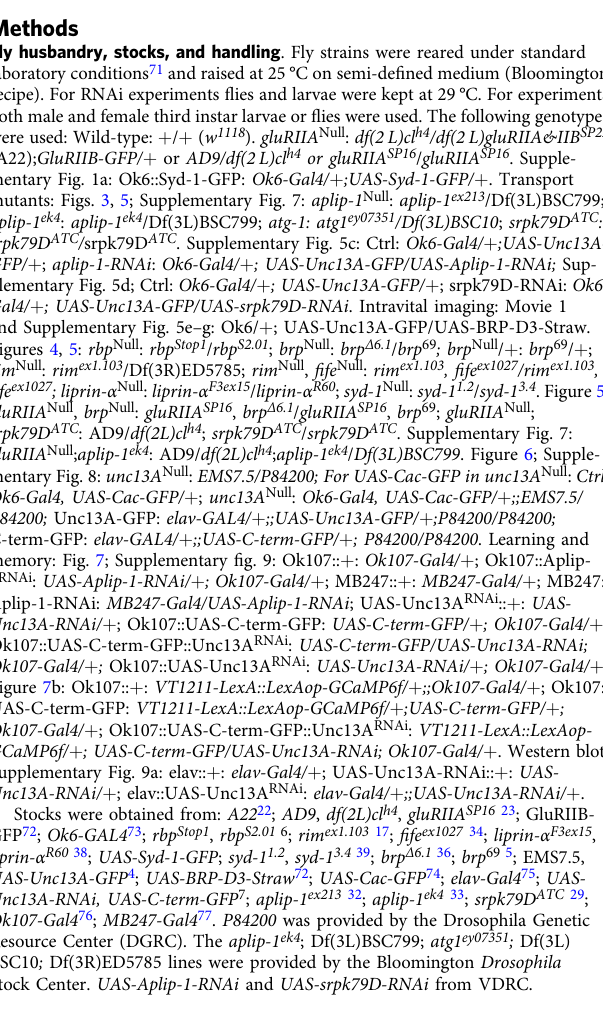
mentary Fig. 1a: Ok6::Syd-1-GFP: Ok6-Gal4/ + ;UAS-Syd-1-GFP/ + . Transport mutants: Figs. 3, 5; Supplementary Fig. 7: aplip-1 Null : aplip-1 ex213 /Df(3L)BSC799; aplip-1 ek4 : aplip-1 ek4 /Df(3L)BSC799; atg-1: atg1 ey07351 /Df(3L)BSC10 ; srpk79D ATC : srpk79D ATC / srpk79D ATC . Supplementary Fig. 5c: Ctrl: Ok6-Gal4/ + ;UAS-Unc13A- GFP/ + ; aplip-1-RNAi : Ok6-Gal4/ + ; UAS-Unc13A-GFP/UAS-Aplip-1-RNAi; Sup- plementary Fig. 5d; Ctrl: Ok6-Gal4/ + ; UAS-Unc13A-GFP/ + ; srpk79D-RNAi: Ok6- Gal4/ + ; UAS-Unc13A-GFP/UAS-srpk79D-RNAi . Intravital imaging: Movie 1 and Supplementary Fig. 5e – g: Ok6/ + ; UAS-Unc13A-GFP/UAS-BRP-D3-Straw. Figures 4, 5: rbp Null : rbp Stop1 / rbp S2.01 ; brp Null : brp Δ 6.1 / brp 69 ; brp Null / + : brp 69 / + ; rim Null : rim ex1.103 /Df(3R)ED5785; rim Null , fi fe Null : rim ex1.103 , fi fe ex1027 /rim ex1.103 , fi fe ex1027 ; liprin- α Null : liprin- α F3ex15 / liprin- α R60 ; syd-1 Null : syd-1 1.2 / syd-1 3.4 . Figure 5: gluRIIA Null , brp Null : gluRIIA SP16 , brp Δ 6.1 / gluRIIA SP16 , brp 69 ; gluRIIA Null ; srpk79D ATC : AD9/ df(2L)cl h4 ; srpk79D ATC / srpk79D ATC . Supplementary Fig. 7: gluRIIA Null ; aplip-1 ek4 : AD9/ df(2L)cl h4 ; aplip-1 ek4 / Df(3L)BSC799 . Figure 6; Supple- mentary Fig. 8: unc13A Null : EMS7.5/P84200; For UAS-Cac-GFP in unc13A Null : Ctrl: Ok6-Gal4, UAS-Cac-GFP/ + ; unc13A Null : Ok6-Gal4, UAS-Cac-GFP/ + ;;EMS7.5/ P84200; Unc13A-GFP: elav-GAL4/ + ;;UAS-Unc13A-GFP/ + ;P84200/P84200; C-term-GFP: elav-GAL4/ + ;;UAS-C-term-GFP/ + ; P84200/P84200 . Learning and memory: Fig. 7; Supplementary fi g. 9: Ok107:: + : Ok107-Gal4/ + ; Ok107::Aplip- 1 RNAi : UAS-Aplip-1-RNAi/ + ; Ok107-Gal4/ + ; MB247:: + : MB247-Gal4/ + ; MB247:: Aplip-1-RNAi: MB247-Gal4/UAS-Aplip-1-RNAi ; UAS-Unc13A RNAi :: + : UAS- Unc13A-RNAi/ + ; Ok107::UAS-C-term-GFP: UAS-C-term-GFP/ + ; Ok107-Gal4/ + : Ok107::UAS-C-term-GFP::Unc13A RNAi : UAS-C-term-GFP/UAS-Unc13A-RNAi; Ok107-Gal4/ + ; Ok107::UAS-Unc13A RNAi : UAS-Unc13A-RNAi/ + ; Ok107-Gal4/ + . Figure 7b: Ok107:: + : VT1211-LexA::LexAop-GCaMP6f/ + ;;Ok107-Gal4/ + ; Ok107:: UAS-C-term-GFP: VT1211-LexA::LexAop-GCaMP6f/ + ;UAS-C-term-GFP/ + ; Ok107-Gal4/ + ; Ok107::UAS-C-term-GFP::Unc13A RNAi : VT1211-LexA::LexAop- GCaMP6f/ + ; UAS-C-term-GFP/UAS-Unc13A-RNAi; Ok107-Gal4/ + . Western blot, Supplementary Fig. 9a: elav:: + : elav-Gal4/ + ; UAS-Unc13A-RNAi:: + : UAS- Unc13A-RNAi/ + ; elav::UAS-Unc13A RNAi : elav-Gal4/ + ;;UAS-Unc13A-RNAi/ + . Stocks were obtained from: A22 22 ; AD9 , df(2L)cl h4 , gluRIIA SP16 23 ; GluRIIB- GFP 72 ; Ok6-GAL4 73 ; rbp Stop1 , rbp S2.01 6 ; rim ex1.103 17 ; fi fe ex1027 34 ; liprin- α F3ex15 , liprin- α R60 38 ; UAS-Syd-1-GFP ; syd-1 1.2 , syd-1 3.4 39 ; brp Δ 6.1 36 ; brp 69 5 ; EMS7.5, UAS-Unc13A-GFP 4 ; UAS-BRP-D3-Straw 72 ; UAS-Cac-GFP 74 ; elav-Gal4 75 ; UAS- Unc13A-RNAi, UAS-C-term-GFP 7 ; aplip-1 ex213 32 ; aplip-1 ek4 33 ; srpk79D ATC 29 ; Ok107-Gal4 76 ; MB247-Gal4 77 . P84200 was provided by the Drosophila Genetic Resource Center (DGRC). The aplip-1 ek4 ; Df(3L)BSC799; atg1 ey07351 ; Df(3L) BSC10 ; Df(3R)ED5785 lines were provided by the Bloomington Drosophila Stock Center. UAS-Aplip-1-RNAi and UAS-srpk79D-RNAi from